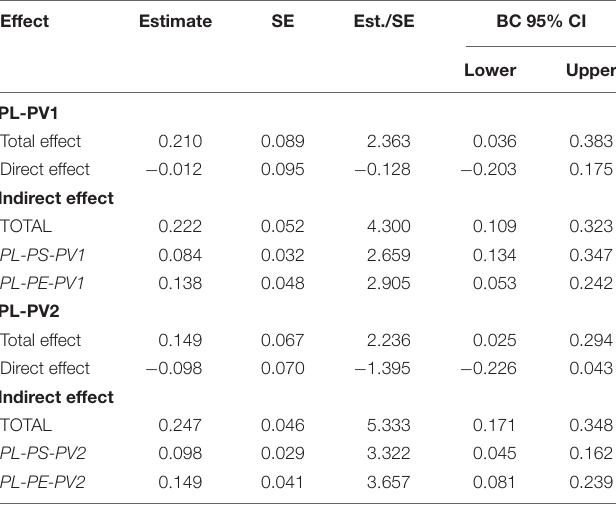
TABLE 4 | Results of mediating